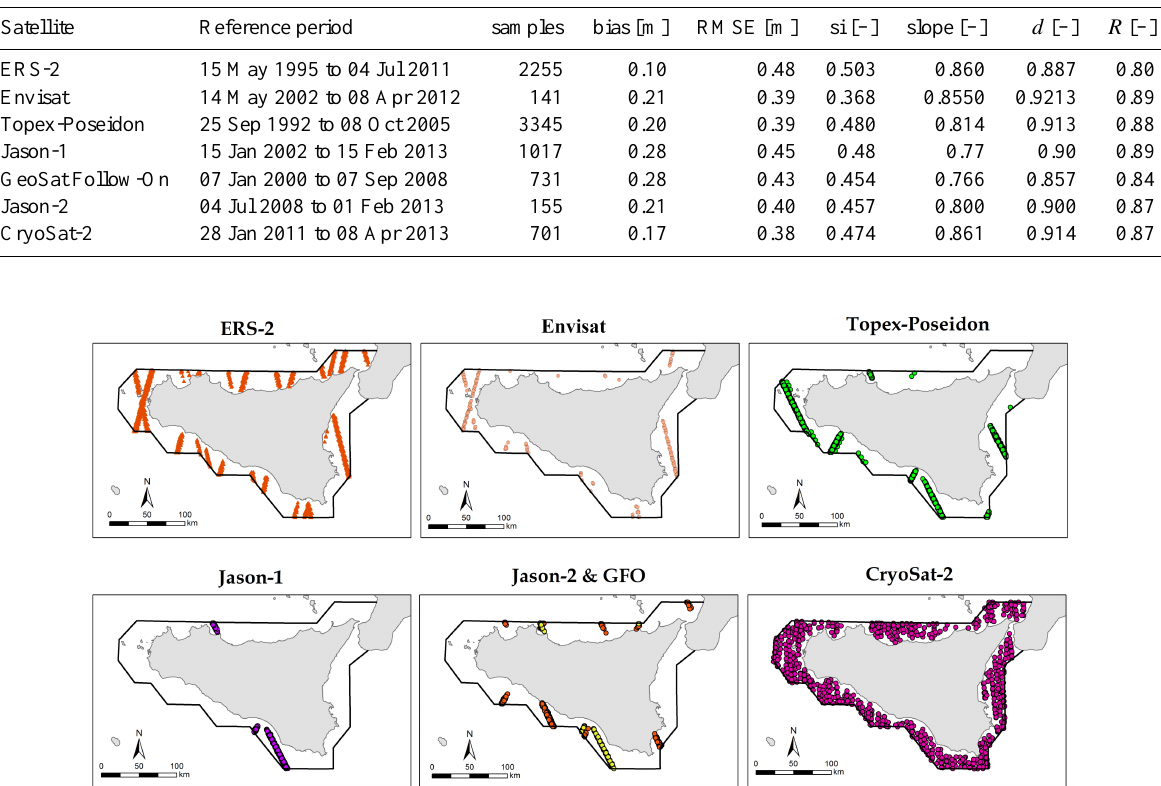
Figure 4. Observation points from satellites, selected within the computational domain for validating SWAN model results.